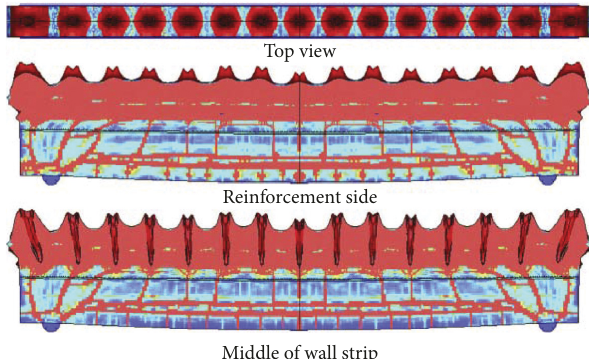
Figure 15: Damage in RC wall strip loaded with only fragment impacts [3].